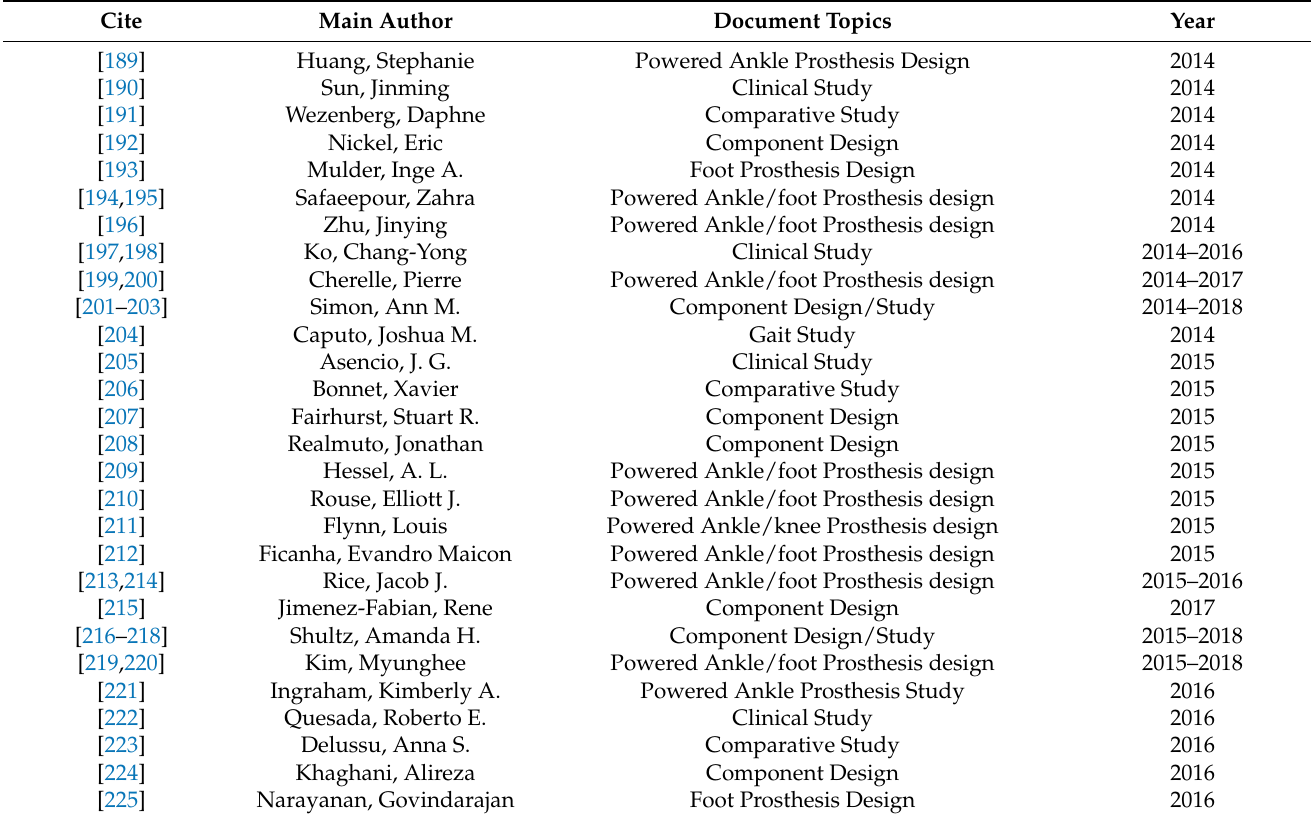
Figure 5. Top patent applicants for lower limb prosthesis. Table 2. Articles analyzed for ankle/foot